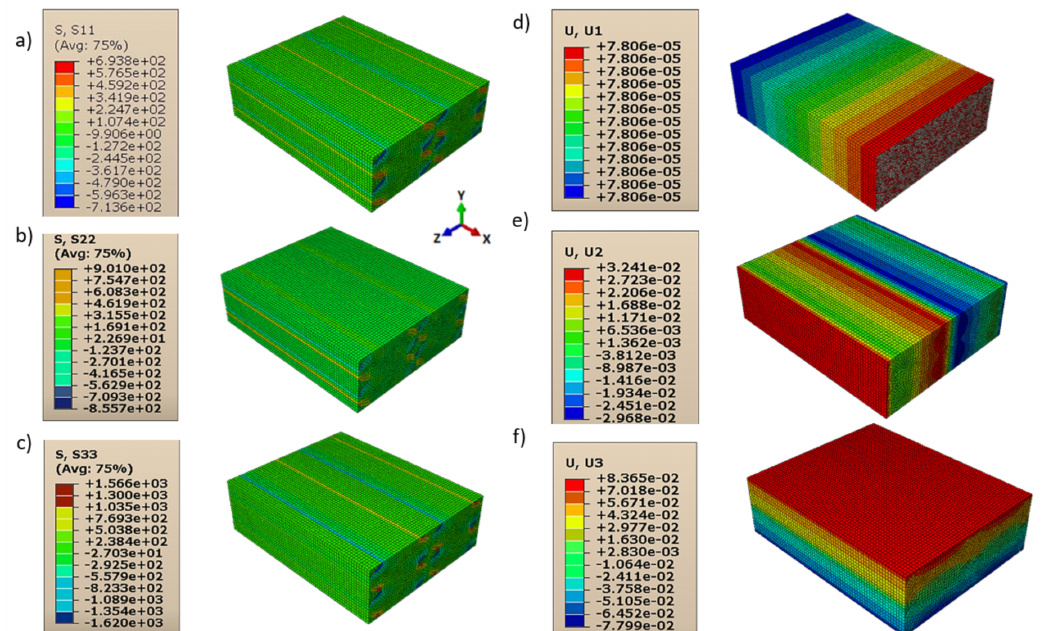
Figure 15. Load cases to evaluate G 23 : ( a ) stress in direction 11; ( b ) stress in direction 22; ( c ) stress in direction 33; ( d ) displacement in direction 11; ( e ) displacement in direction 22; ( f ) displacement in direction 33.